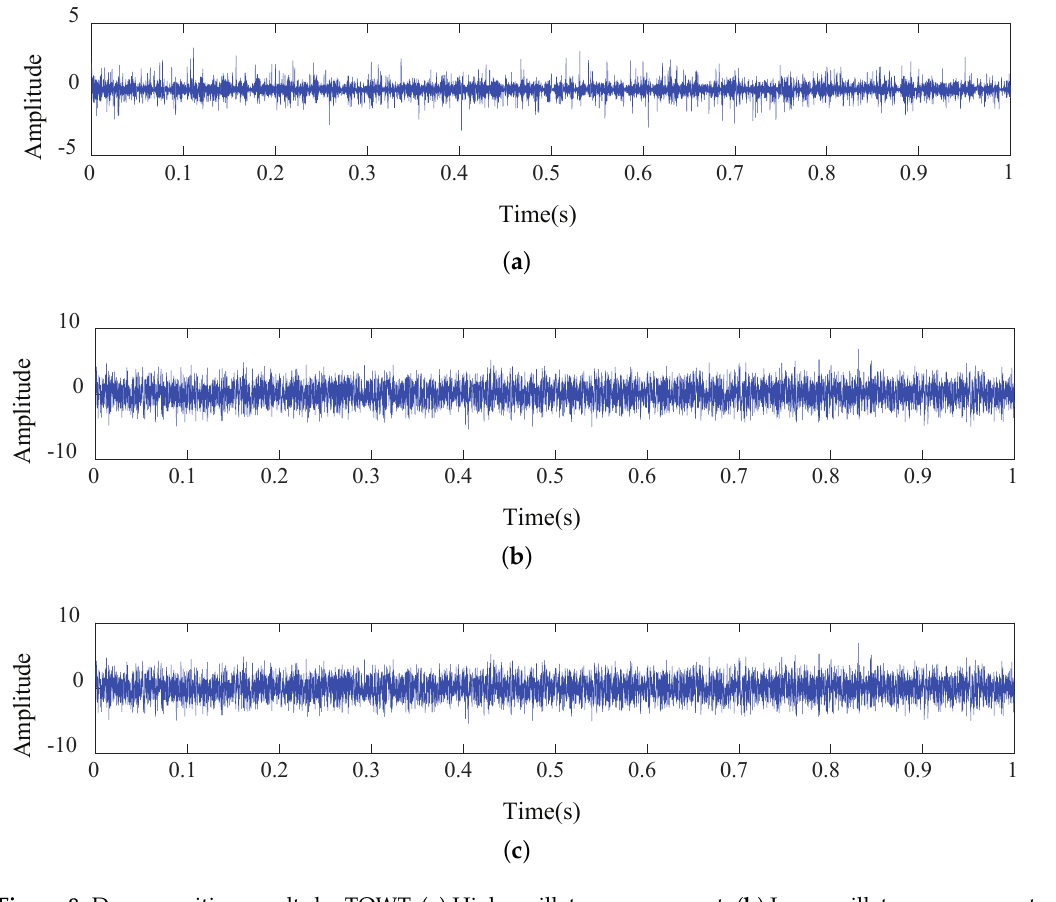
Figure 8. Decomposition results by TQWT: ( a ) High oscillatory component. ( b ) Low oscillatory component. ( c ) Residual